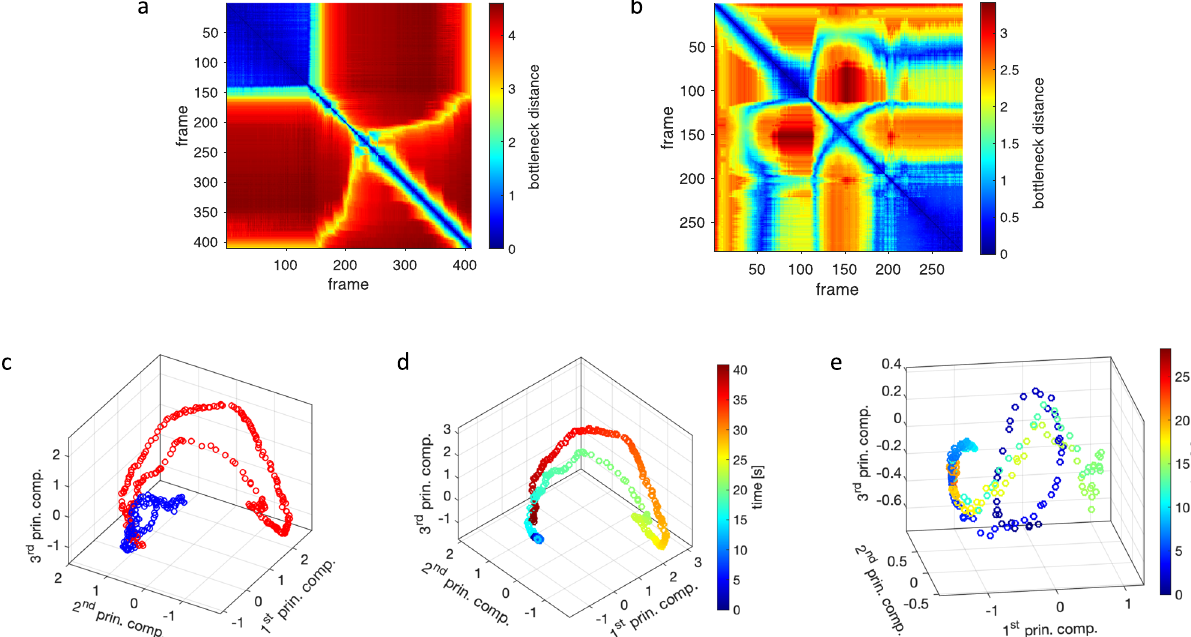
Fig. 4 Bottleneck distance matrices and 3D representation of the topological pathways of the 6 μ m capillary. The bottleneck distance matrices associated to ( a ) the nematic-isotropic and ( b ) the isotropic-nematic phase transitions; the frame rate is 10 fps. c 3D-projections of the heating (red) and cooling (blue) Euclidean topological pathways. The three-principal axes correspond to the three coordinates of the Euclidean embedding with the largest positive eigenvalues. d Nematic-isotropic and ( e ) isotropic-nematic Euclidean topological pathways. In d and e colour codes time from beginning (blue) to the end (red).